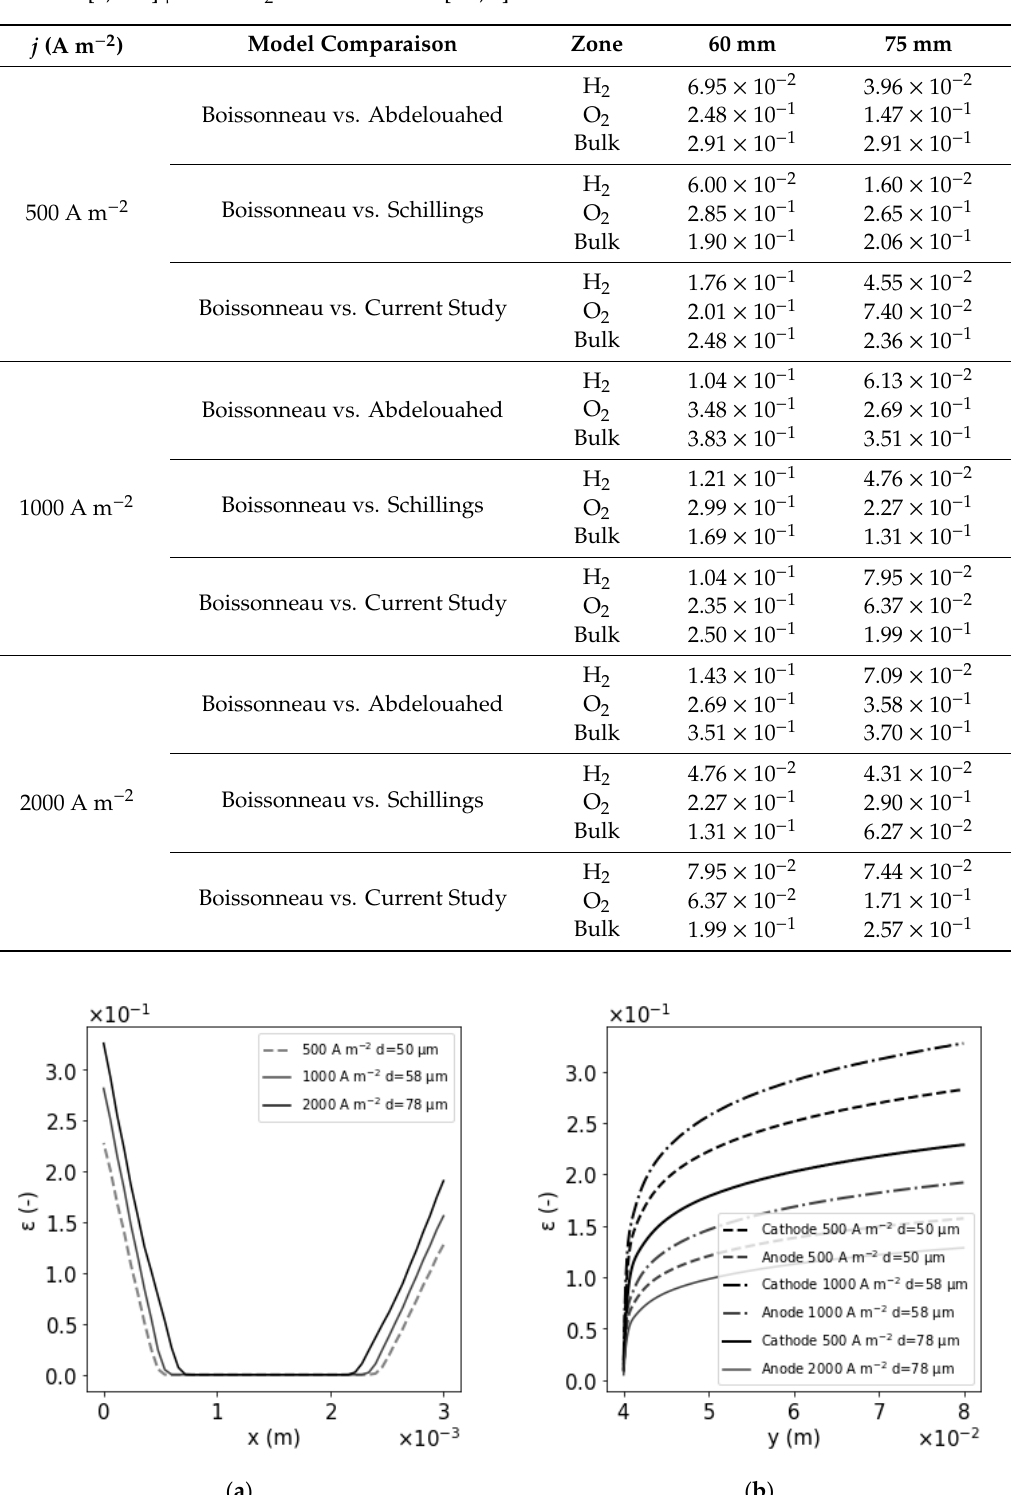
Table 4. Average relative difference of the different model compared to Boissonneau et al. [15] at two vertical positions 60 and 75 mm and three horizontal zones for the three current density. H 2 is the zone between [0, 500] µm and O 2 is zone between [2.5, 3] mm.